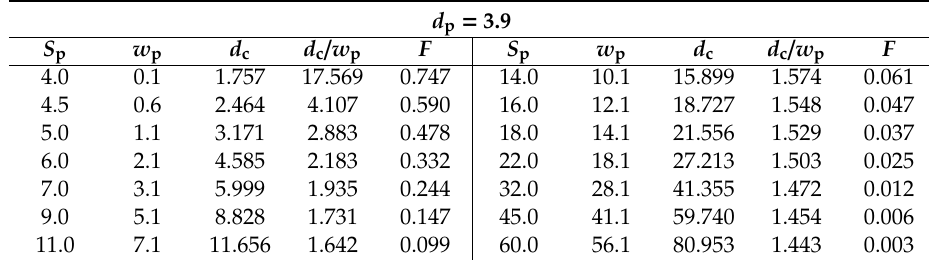
Table 1. Geometrical parameters of post arrays with constant post diameter d p defined in the text; 1 length unit ≈ 2.5